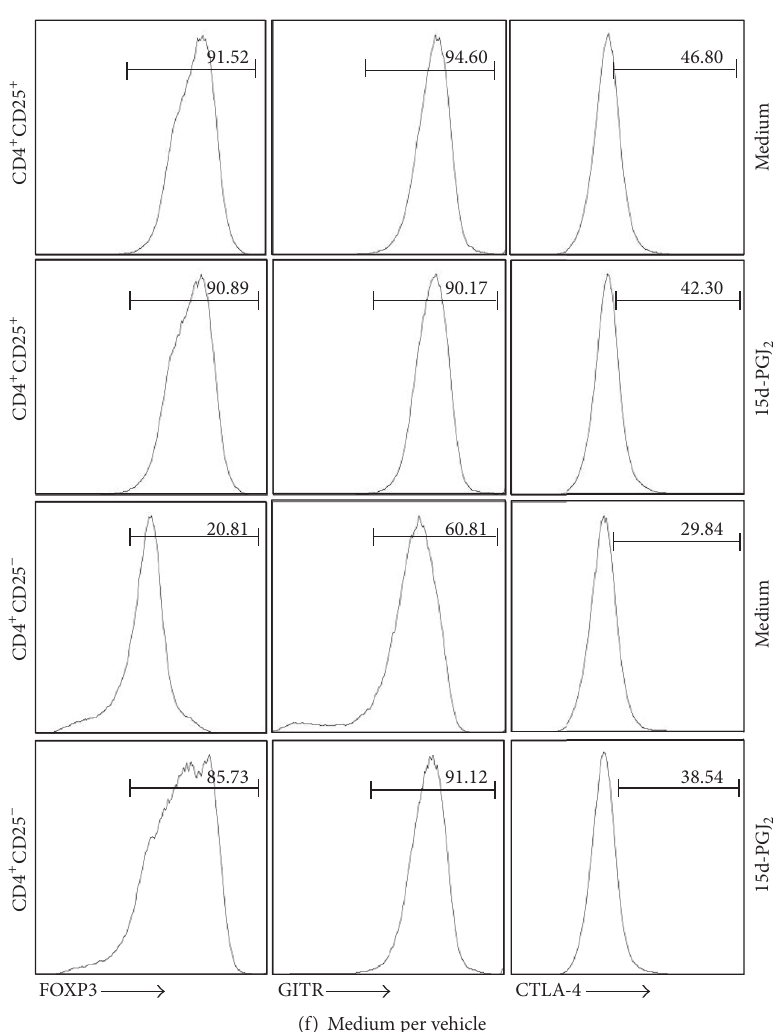
Figure 5: 15d-PGJ 2 induces regulatory T cell markers in conventional T cells. (a) FOXP3 mRNA expression was quantified by real-time PCR in draining lymph nodes from na¨ıve mice (white bar) or collagen-immunized and challenged DBA/1 mice treated with vehicle (black bar) or 15d-PGJ 2 (hatched bar) after 7 days of treatment. Results are presented as the mean ± SEM, 𝑁 = 6 ; ∗ 𝑃 < 0.05 compared with PBS-treated group. Total cells (2 × 10 6 cells/mL) from the draining lymph nodes from na¨ıve or arthritic animals were in vitro incubated with 15d-PGJ 2 (5 𝜇 M) (black bars) or vehicle (DMSO) (white bars) for 96 hours on plates coated with 𝛼 -CD3. The nonadherent cells were phenotyped by flow cytometry using specific antibodies: anti-CD3 conjugated with FITC, anti-CD4 conjugated with PerCP, and anti-CD25 conjugated with APC-Cy7 (b) and anti-FOXP3 (c), anti-GITR (d), and anti-CTLA-4 (e) conjugated with PE. Lymphocytes were gated on CD4 + CD25 + or CD4 + CD25 − , and the population expressing the markers described above was subsequently analyzed. In (f), representative histograms of FOXP3, CTLA-4, and GITR are shown in each box. The values above are expressed as the mean ± SEM, which are representative of quadruplicate samples from two independent experiments ( 𝑁 = 4 ). # 𝑃 < 0.05 compared with CD4 + CD25 − group control